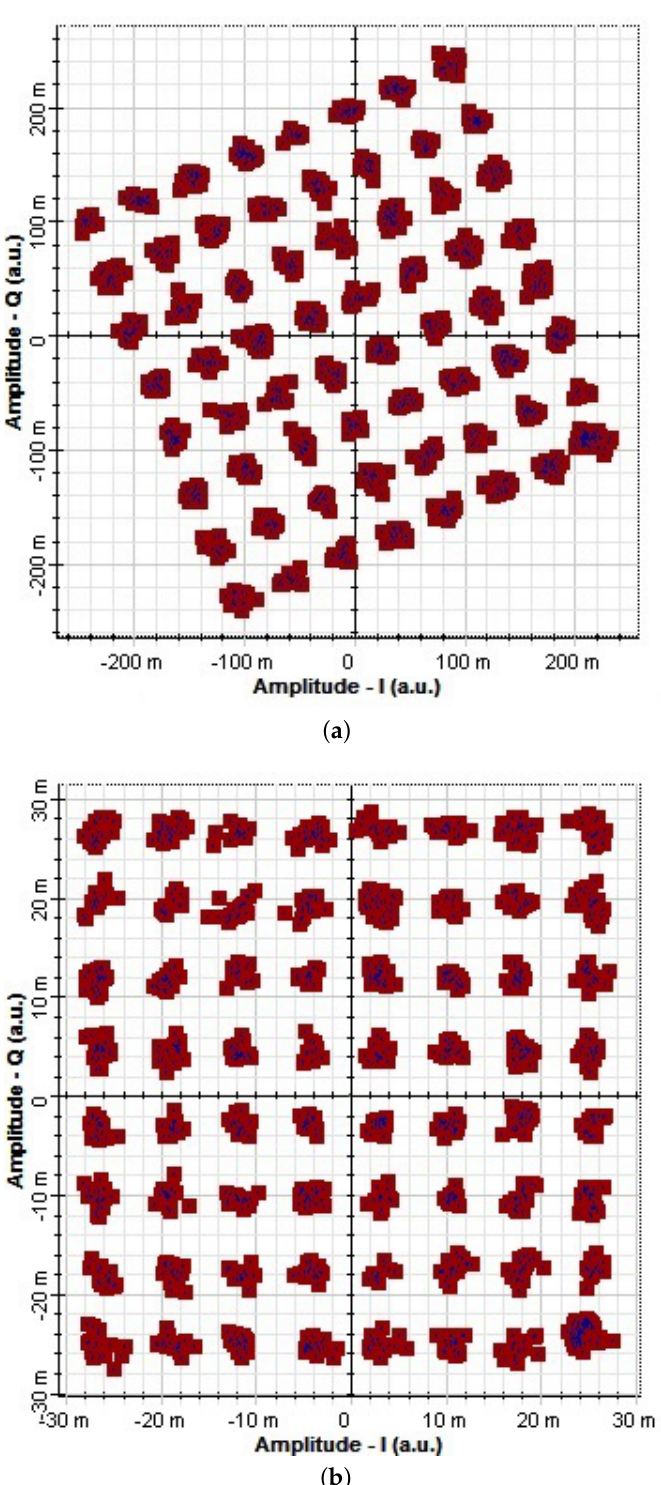
Figure 7. ( a ) Distort constellation analyzer diagram of unencrypted ON. ( b ) Constellation diagram of protected